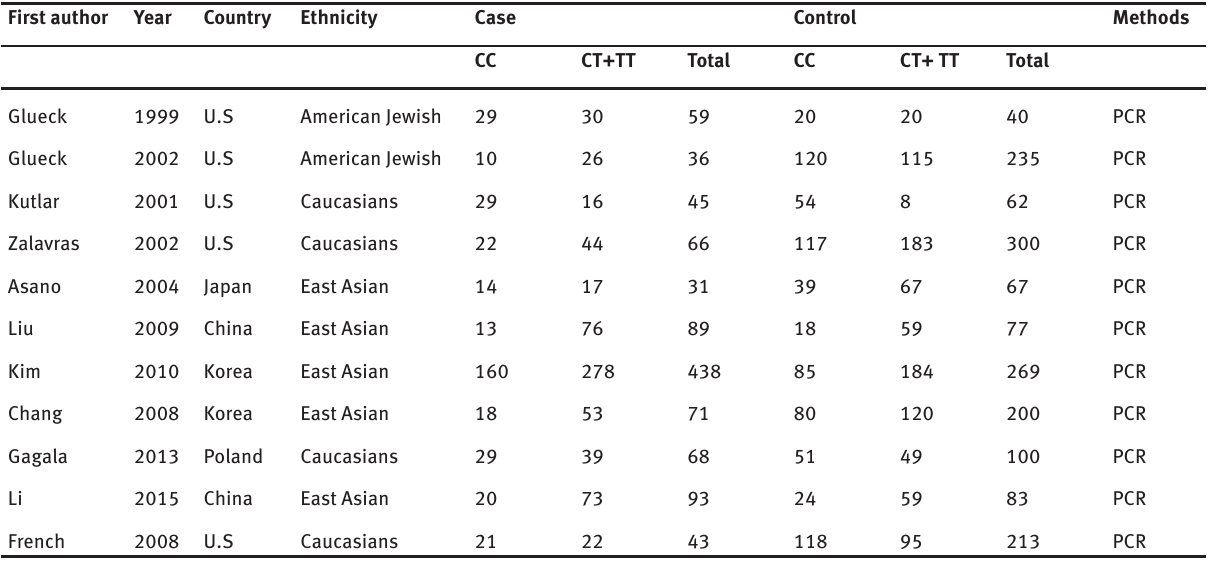
Table 1: General information for the included 11 studies.